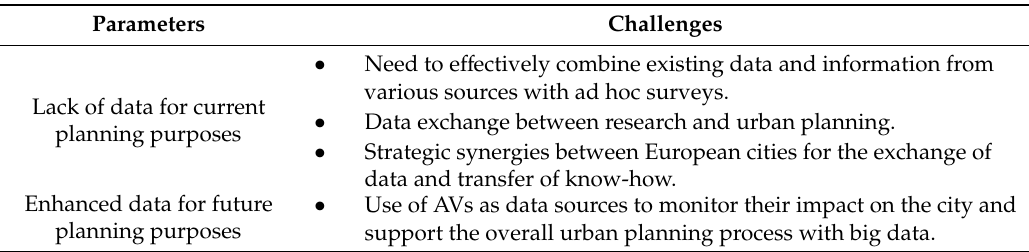
Table 3. Parameters regarding the current lack of data and the enhanced data availability in the future due to the implementation of AVs and relevant challenges for urban planning in